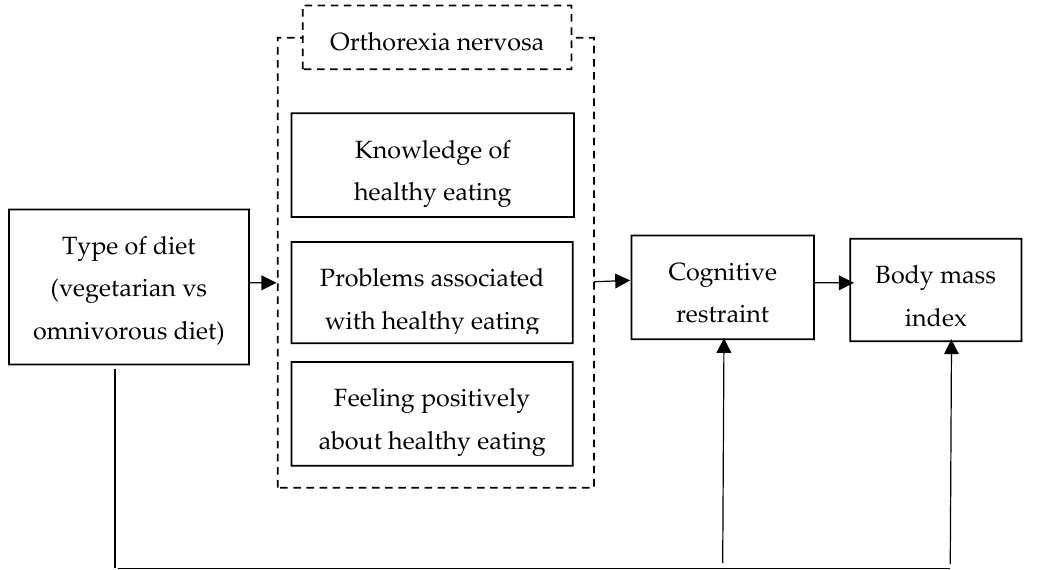
Figure 1. Conceptual model for the association between vegetarian versus omnivorous diet and unhealthy eating patterns (orthorexia nervosa, cognitive restraint) and body mass index in adult population.